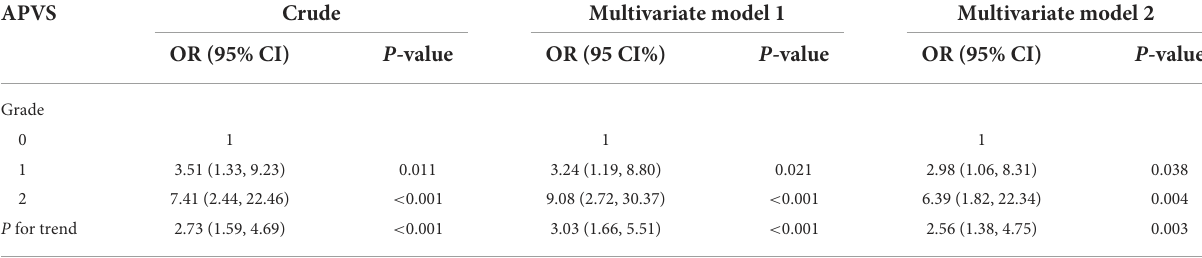
Crude:APVSgradesenrolledinmultivariatebinaryregression. Multivariatemodel1:Ageandsexwereadjusted. Multivariatemodel2:Age,sex,infarctvolume,etiologyofTOASTclassification,andwhitematterhyperintensitieswereadjusted.APVSgradeswereenrolledintheregressionascategorical (P)andnumerical(Pfortrend)variables. APVS,asymmetricalprominentveinssign;END,earlyneurologicaldeterioration;TOAST,TrialofOrg10172inAcuteStrokeTreatment.